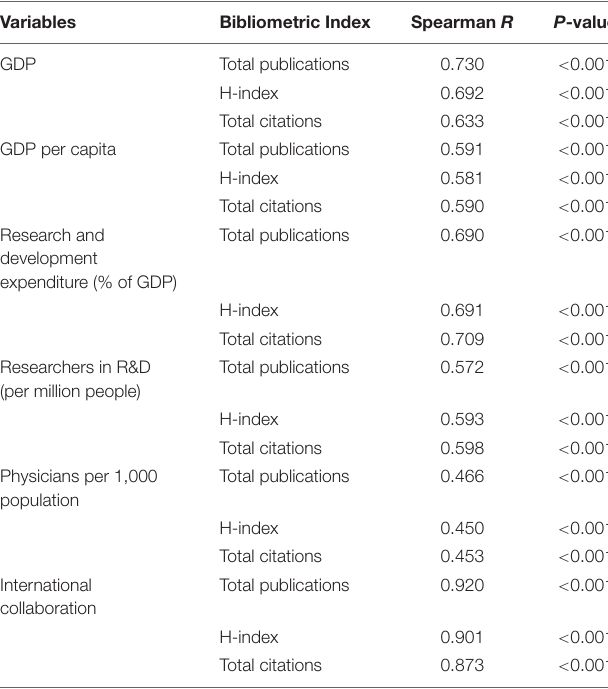
Frontiers in Psychology |